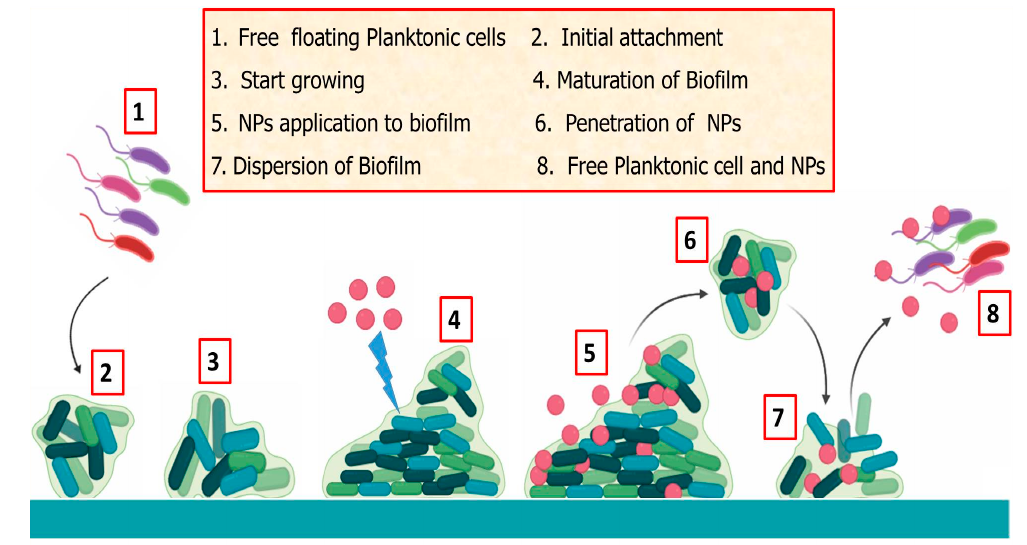
Figure 4. Graphical representation of the antifouling activity of the algae-mediated NPs.